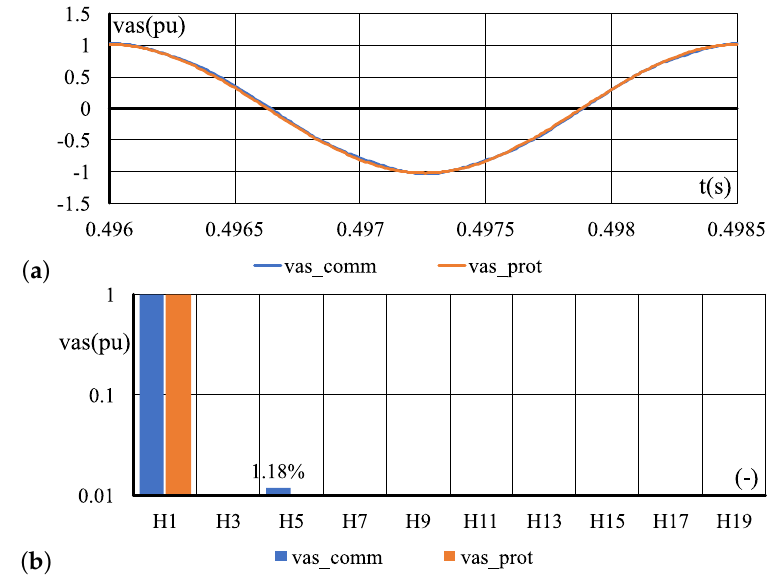
Figure 11. No-load voltage for prototype and commercial BSG: ( a ) back EMF waveform, ( b ) harmonic content of back EMF (vas_prot—measured for prototype BSG, vas_comm—measured for commercial BSG).